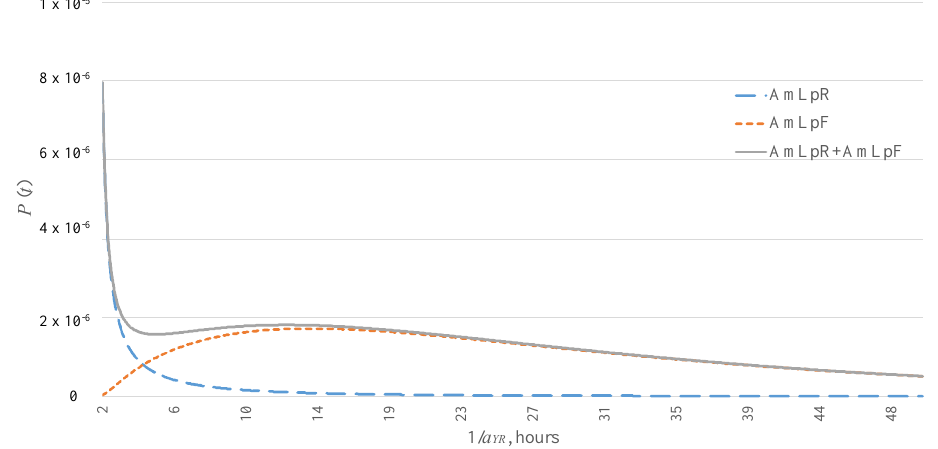
Figure 6. Results of simulation of aging and rejuvenation process using the battery-based model.